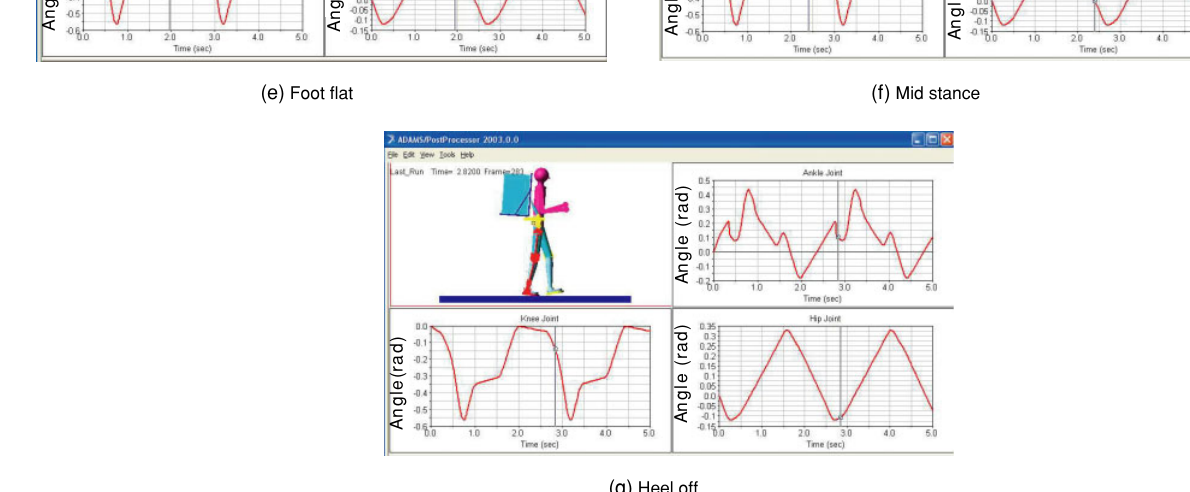
Figure 12 Positions of the legs over a single gait